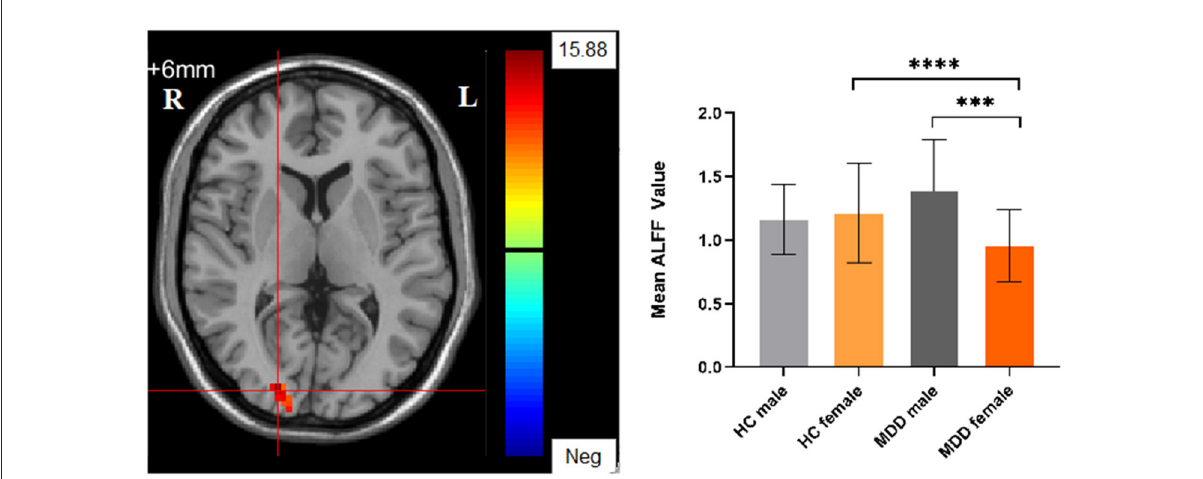
FIGURE3 The diagnosis group × gender group interaction. Regions with diagnosis group × sex group interactions include the right superior occipital gyrus (cluster-level threshold of p < 0.05 after GRF correction). The color bar represents the range of F values. R = right, L = left. The graph shows the ALFF values (mean ± standard deviation) extracted from regions with the diagnosis groups × sex group interaction. The Y-axis represents ALFF values. The X-axis represents 4 groups of participants. **** p < 0.001; *** p < 0.005.